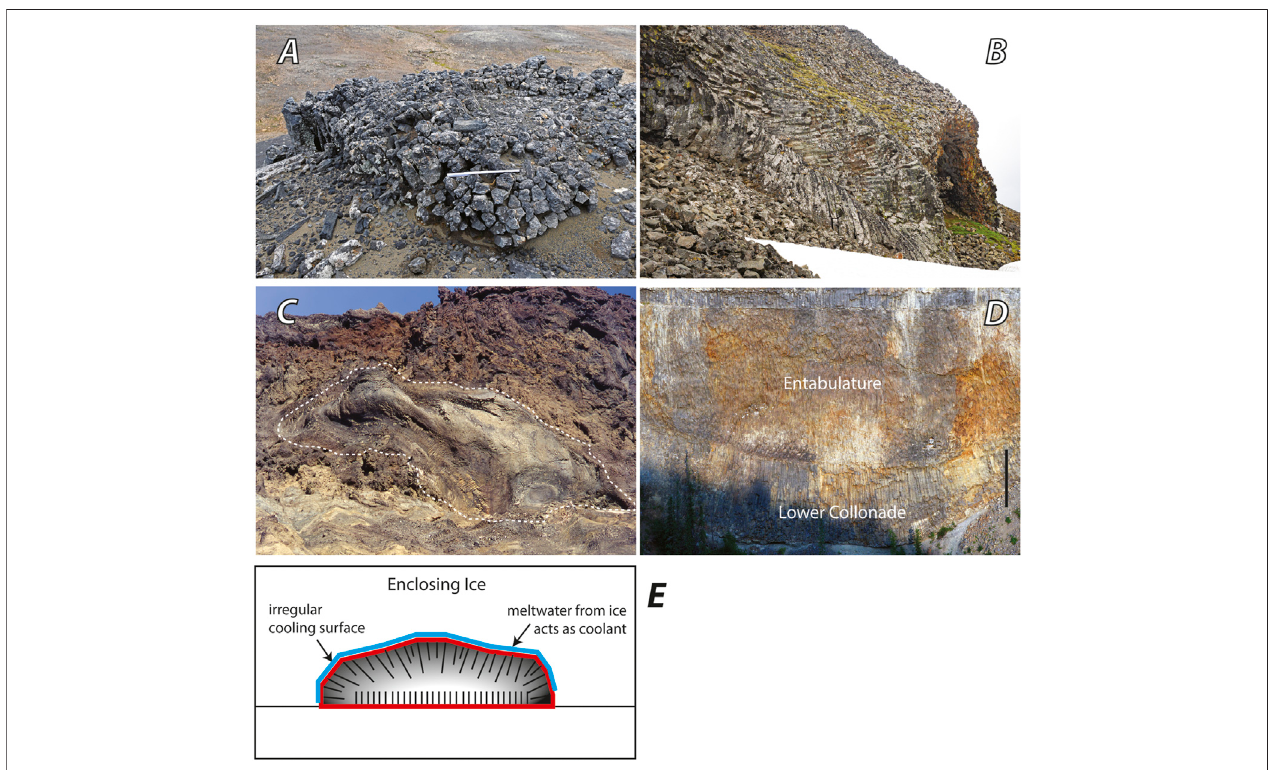
FIGURE 7 | Polygonal jointing examples from glaciovolcanic deposits. (A) Anomalously small columnar joints in basaltic lava at Breidravirki tindar, Iceland. (B) Highly-jointedmassoftrachytewithinbreccia carapaceatHoodooMountainvolcano,BritishColumbia.Jointingisverticalatthecontactsbetween lavaandbreccia,but is rotated through 90 degrees such that it is horizontal in the middle. (C) Radiating joints in ice-con fi ned lava from Mathews Tuya, British Columbia. (D) An example of typical polygonal jointing in a subaerial lava from northern British Columbia, with vertical joints in the basal colonnade and irregular joint orientations in the overlying entabulature. (E) Schematic drawing illustrating joint orientations in a lava emplaced into ice.